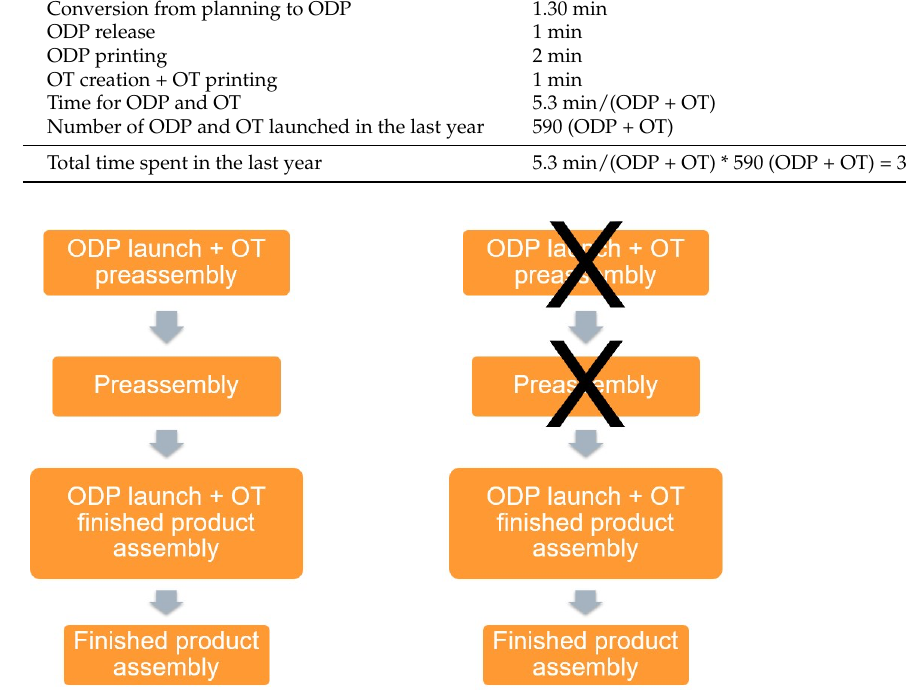
Figure 10. Office process with (“as-is”, left ) and without (“to-be”, right ) the pre-assemblies.